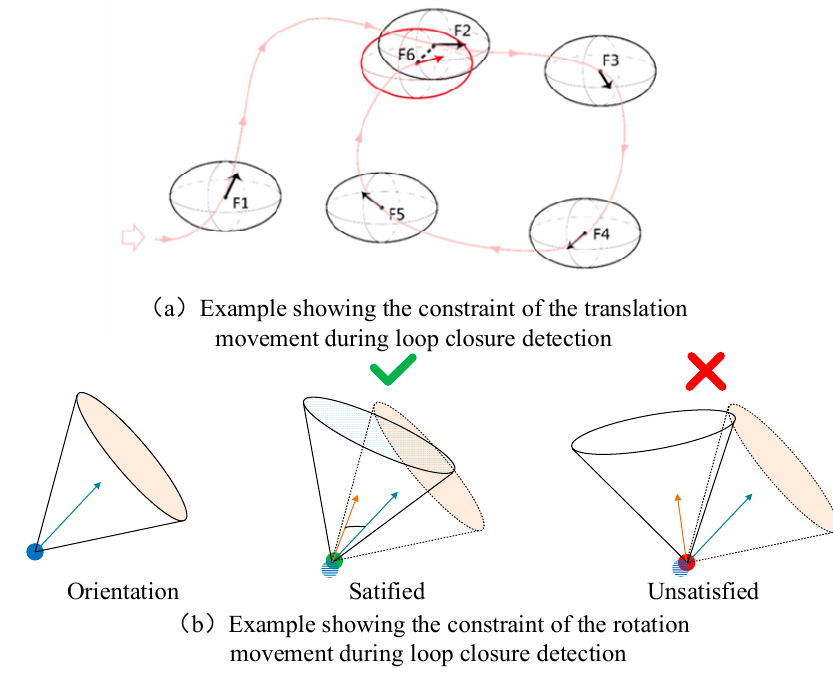
Figure 4. Examples showing the usage of movement metric for loop closure detection.